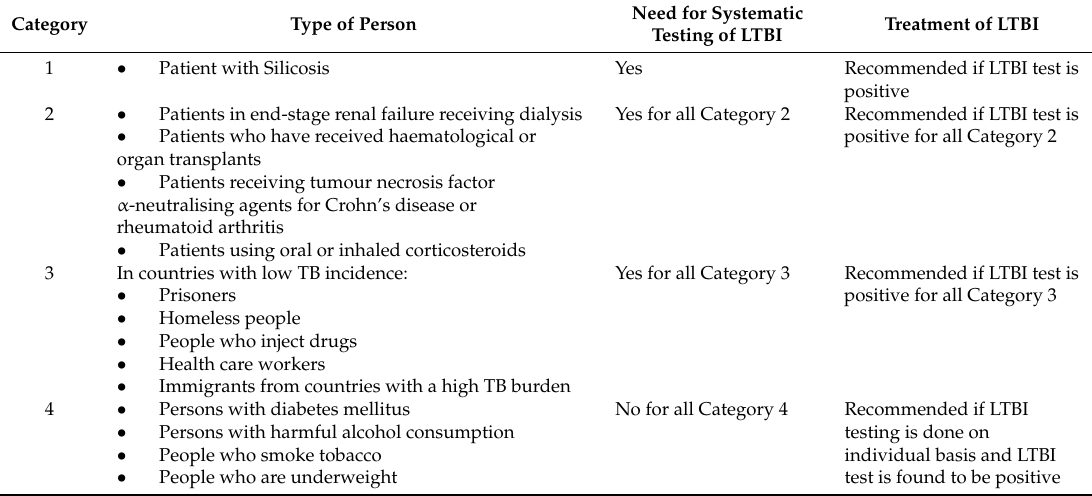
Table 3. Testing and treatment of latent TB infection (LTBI) in HIV-negative high-risk groups who are not household contacts.